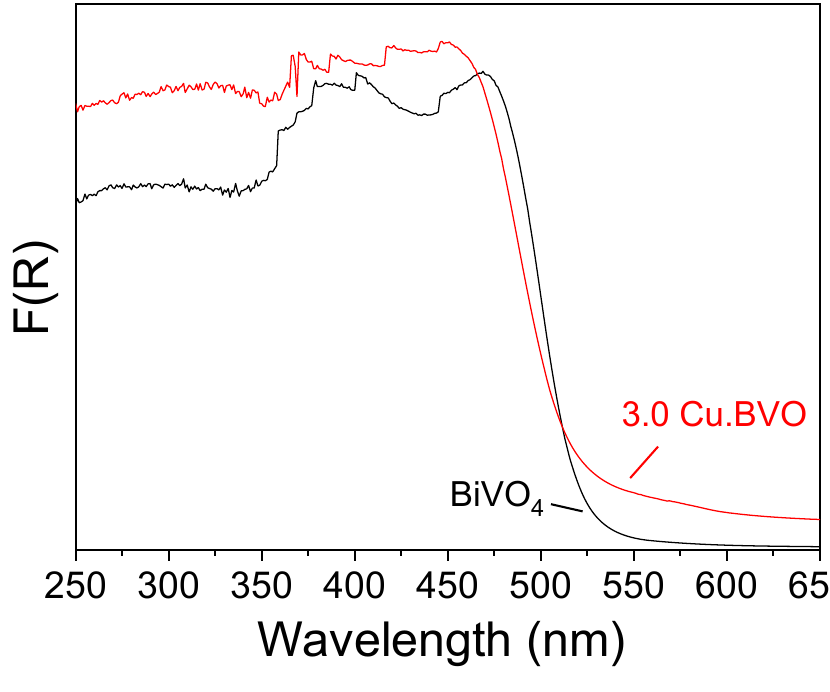
Figure 2. UV ‐ vis diffuse reflectance spectra of BiVO 4 and 3.0 Cu.BVO. Figure 2. UV-vis diffuse reflectance spectra of BiVO 4 and 3.0